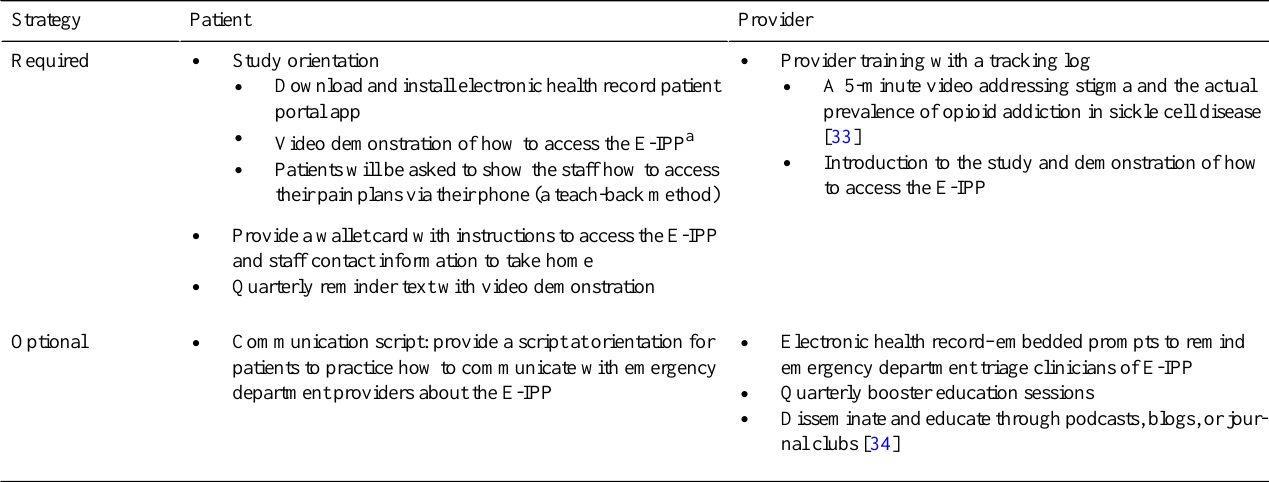
Table 2. Implementation strategies at the patient and provider levels. ProviderPatientStrategy